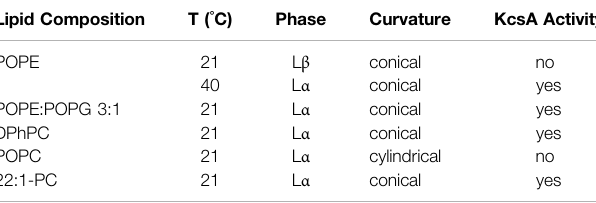
TABLE 2 | Dependence of single channel activity of KcsA on lipid composition measured in painted lipid bilayers. Lipid Composition T ( ° C) Phase Curvature